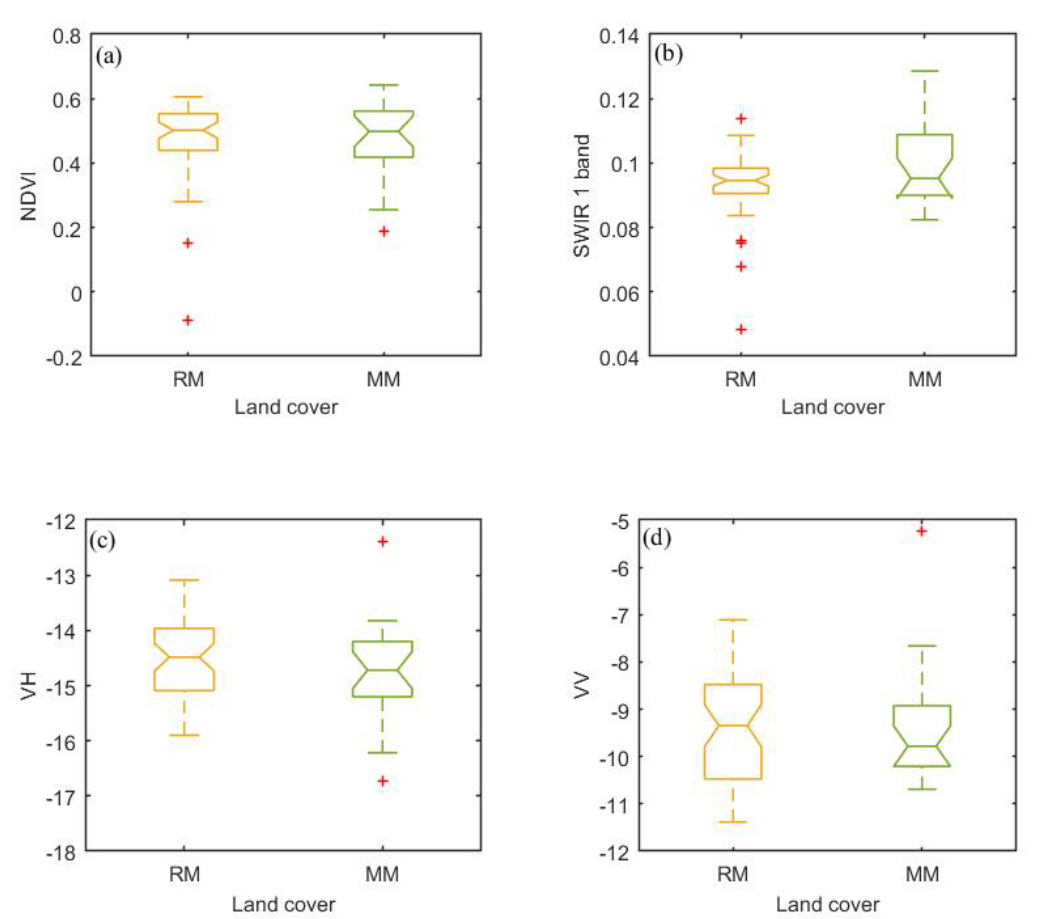
Figure 13. Boxplots of ( a ) NDVI, ( b ) SWIR 1, ( c ) VH, and ( d ) VV for mangroves (RM) and misclassified mangroves (MM).